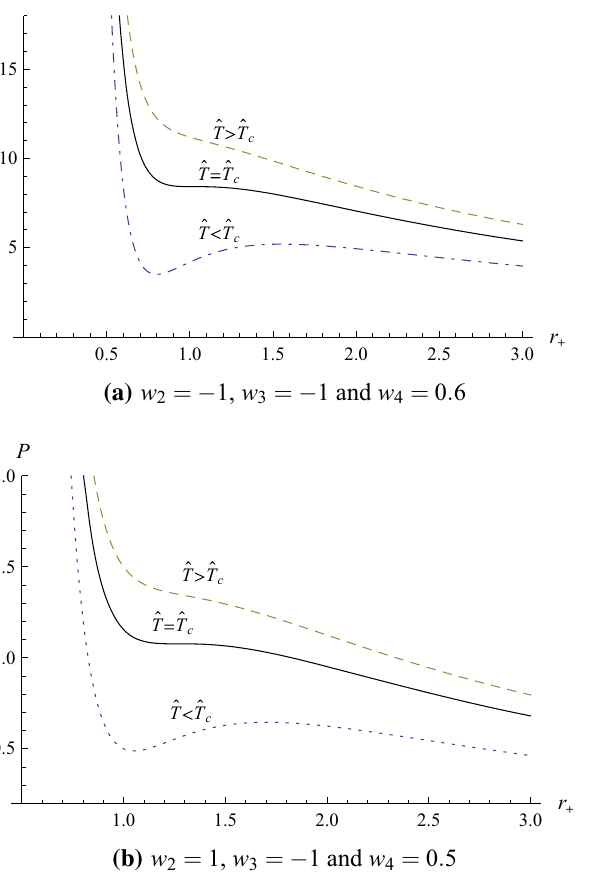
Fig. 2 The P − r + diagrams of six-dimensional AdS black holes. The upper dashed line corresponds to the idea gas phase behavior for ˆ T > ˆ T c .Thecriticaltemperaturecase lines below is with temperatures smaller than the critical temperature. We have ˆ T c = 19 . 2290 in a and ˆ T c = 1 . 1547 in b